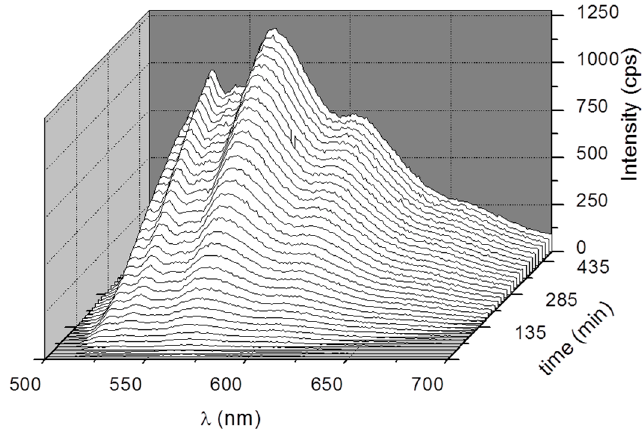
Figure 2. Emission spectra obtained from lipase hydrolysis of QDA 2.0 × 10 − 5 mol ∙ L − 1 in hexane as a function of reaction time ( λ exc = 484 nm, 20 mg of Novozym 435, T = 298 K).